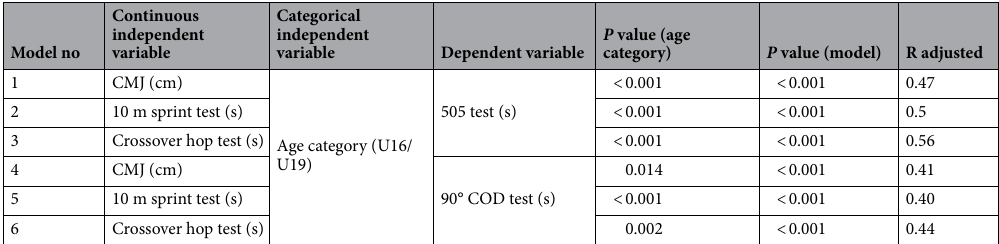
Table 1. Summary of the 6 multiple linear models carried out (including the physical test and the age category as independent variable and the change of direction test as dependent